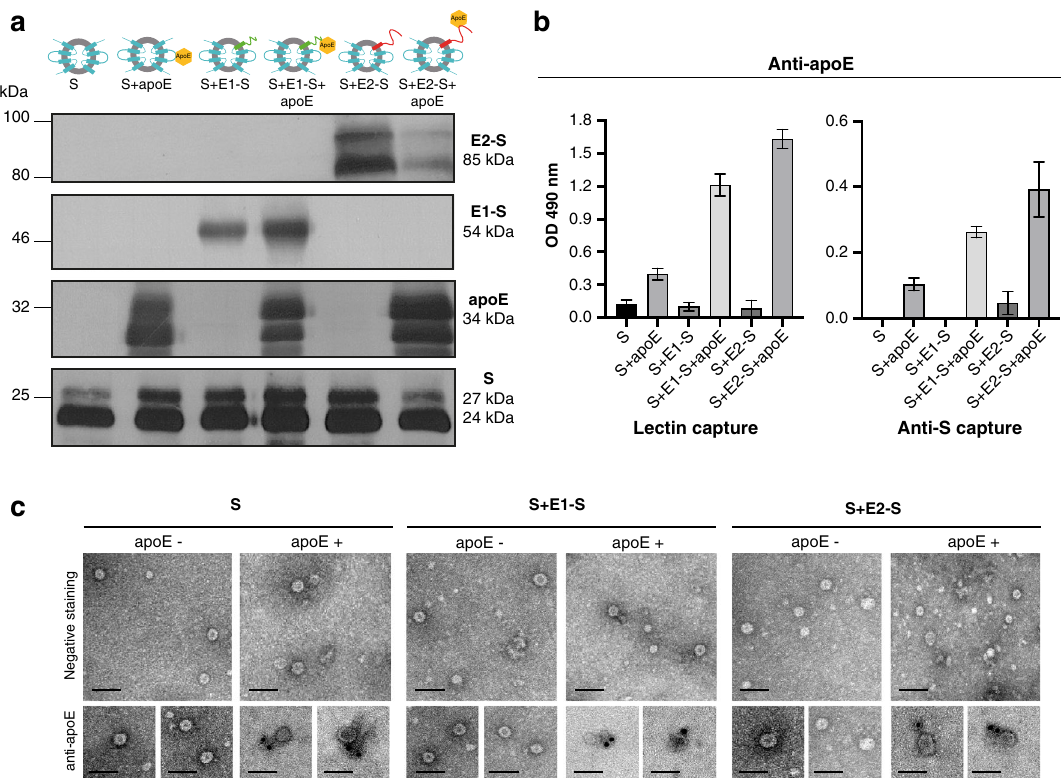
Figure 2. Characterization of the incorporation of apoE and its presentation in purified HBV–HCV subviral particles. ( a ) Western-blot analysis of subviral particles (75 µg/mL SHBsAg) and detection of proteins of interest with the anti-E1 mAb (A4), anti-E2 mAb (H52), anti-S pAb (70-HG15) and anti-apoE pAb (AB947). ( b ) Detection of apoE on the surface of particles by ELISA. Subviral particles (25 µg SHBsAg) were captured with lectin or an anti-S pAb (70-HG15), and apoE was detected with the anti-apoE (AB947) antibody. The experiment was performed once in triplicate, and the results are expressed as mean OD (490 nm) values ± SD. ( c ) Observation of subviral particles by TEM. Particles were analyzed by negative staining with 2% uranyl acetate solution (upper panels) and by the same method after immunogold staining with an anti-apoE pAb (AB947) (lower panels). Scale bars: 50 nm (in upper and lower